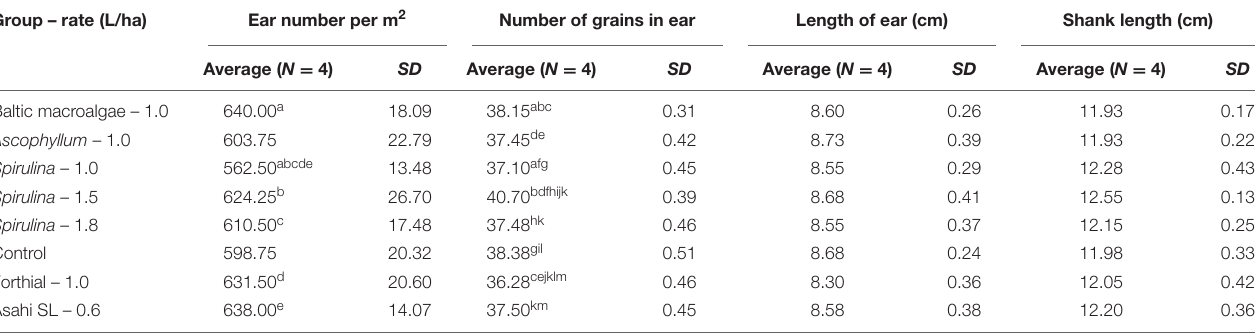
TABLE 4 | Effect of biostimulants on various parameters of winter